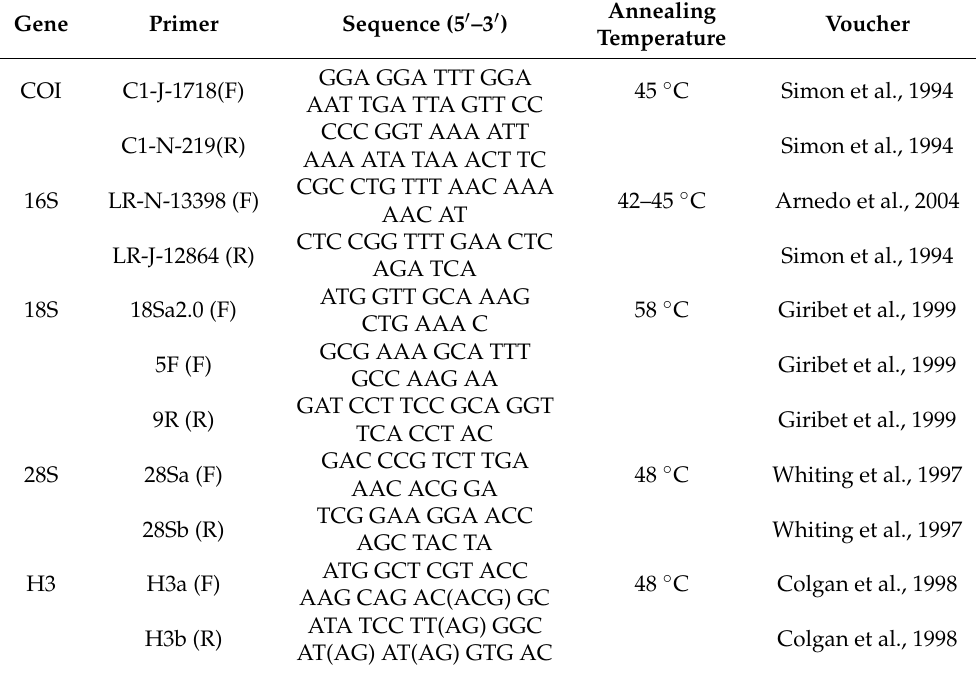
Table 1. Primer sequences, their sources, and reaction conditions used for PCR in this study.